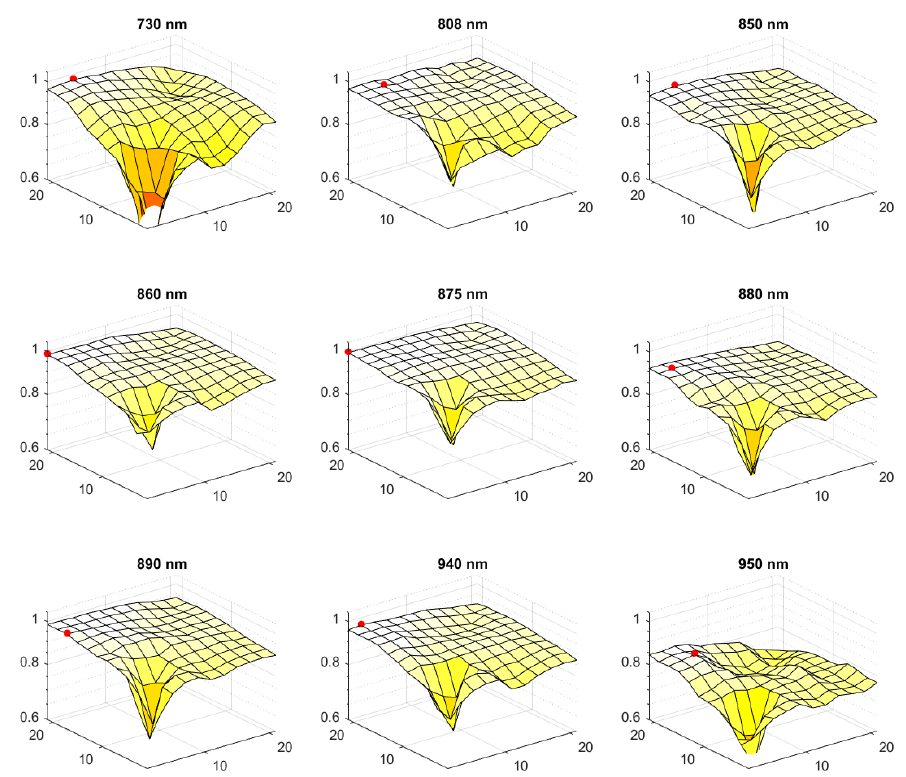
Figure 5. Impact of the window size on verification accuracy. Axis labels for the surface plots are: x,y —dimensions of the operational window in pixels, z —mean ACC . The highest values of ACC were marked with a red